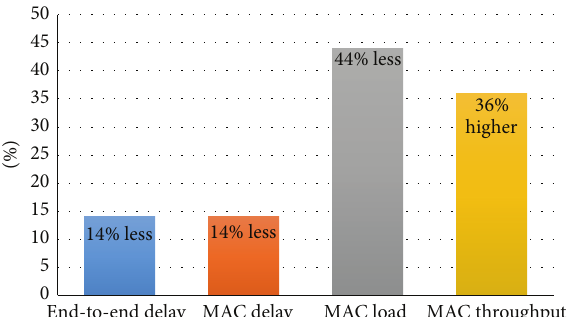
Figure 6: Overall QoS performance summary under proposed